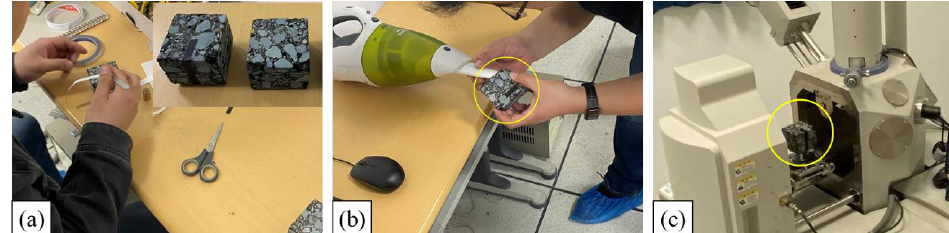
Figure 8. Fine processing of SEM test specimens: ( a ) specimen for pasting conductive adhesive; ( b ) removing impurities on the surface of the specimen; ( c ) the specimen placed in the observation